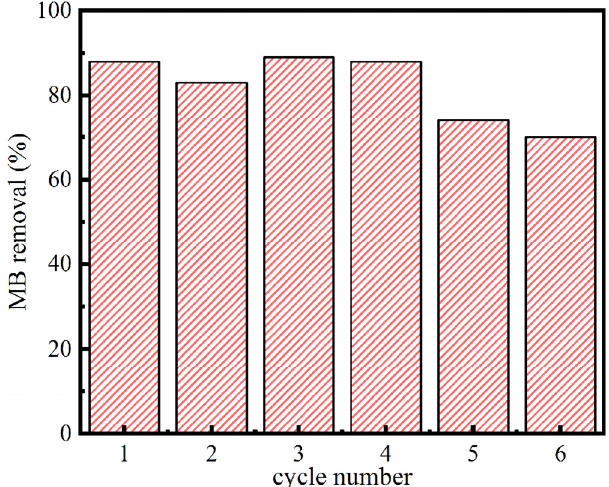
Figure 10. Reusability of Ca-MOF/ABS/TPU skeleton for MB removal.